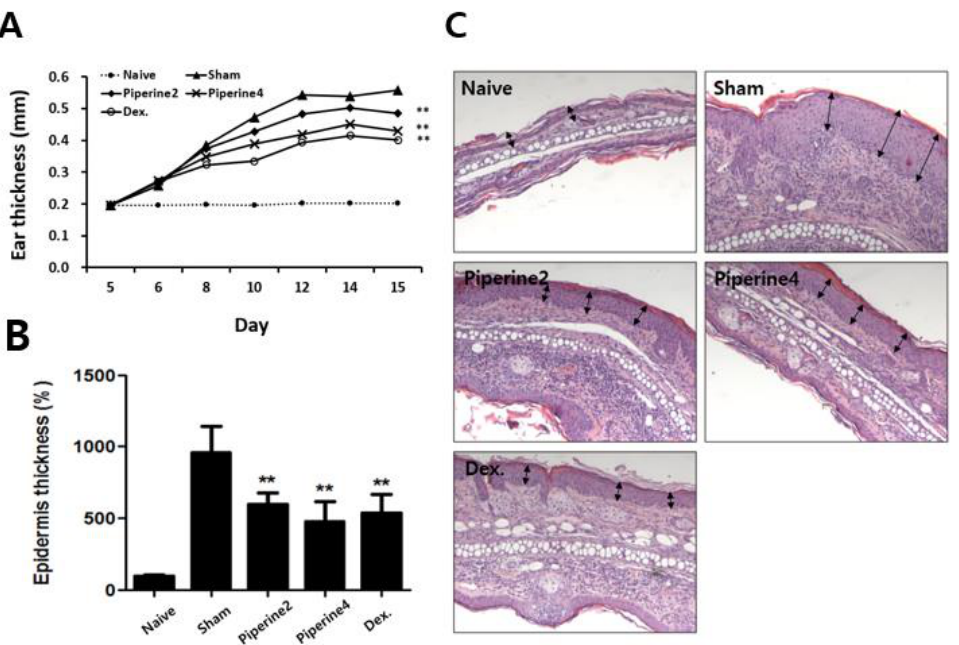
Figure 2. E ff ect of piperine on TMA-induced AD-like symptoms. ( A ) Ear thickness was measured 24 h after the TMA treatment. ( B ) The measurement of epidermal thickness is represented as the relative thickness (%) of the epidermis in the different tested groups of mice versus the sham group. ( C ) Infiltrated inflammatory cells in the ear tissues were stained with hematoxylin and eosin. Arrows indicate epidermal thickness. The results are shown as the means ± SD (Naïve, n = 7; Sham, Piperein2 and 4, n = 10; Dex., n = 8). Asterisks (**) indicate significant differences between the piperine-treated groups and sham groups of TMA-induced AD-like mice at p < 0.01.